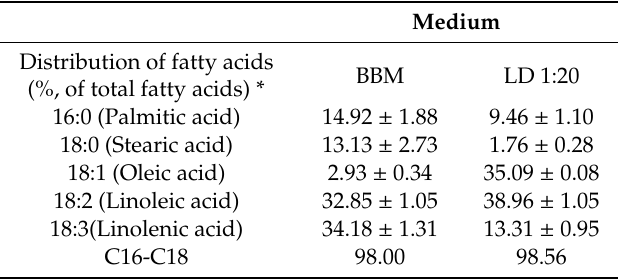
Table 4. Fatty acid composition of A. protothecoides .